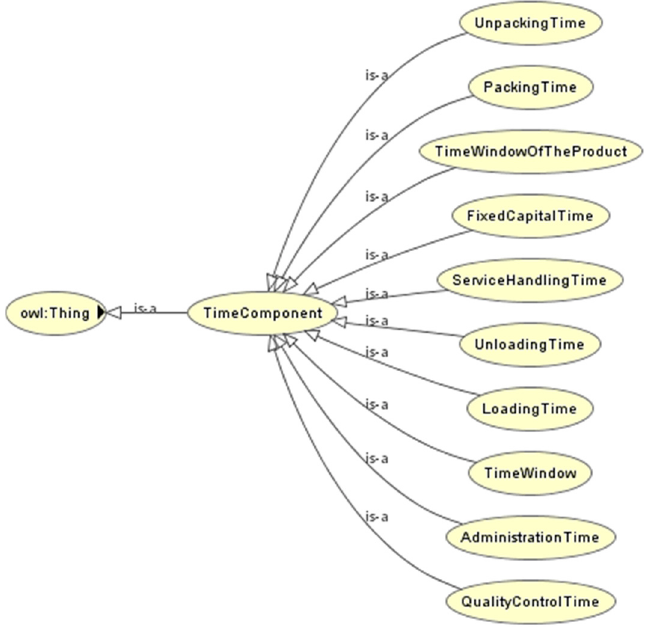
Figure 7. The TimeComponent class.